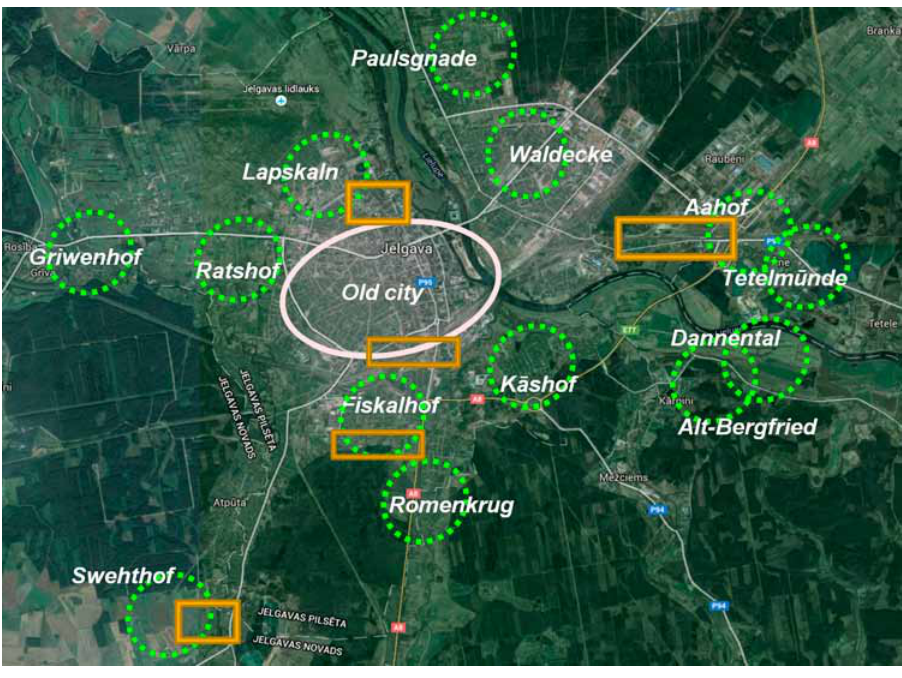
fig. 1. Circumferentially, around the historical center of the city of jelgava, 1–5 km away manor building ensembles were located. 19 th century Source : author ᾽ s